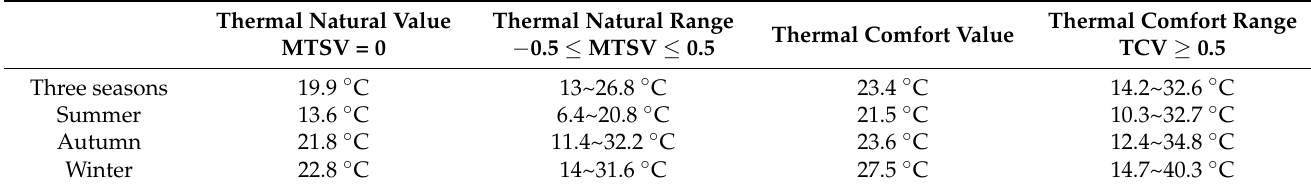
Table 3. The values and ranges of PET for thermal sensation and thermal comfort in summer, autumn, winter, and three seasons.